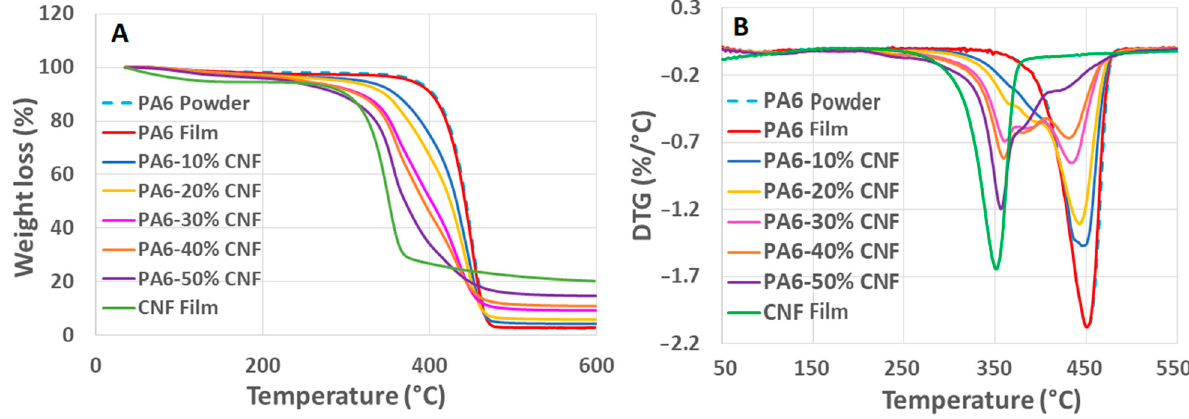
Figure 6. ( A ) TGA curves and ( B ) DTG curves for PA6, CNF, and PA6-CNF nanocomposite films.